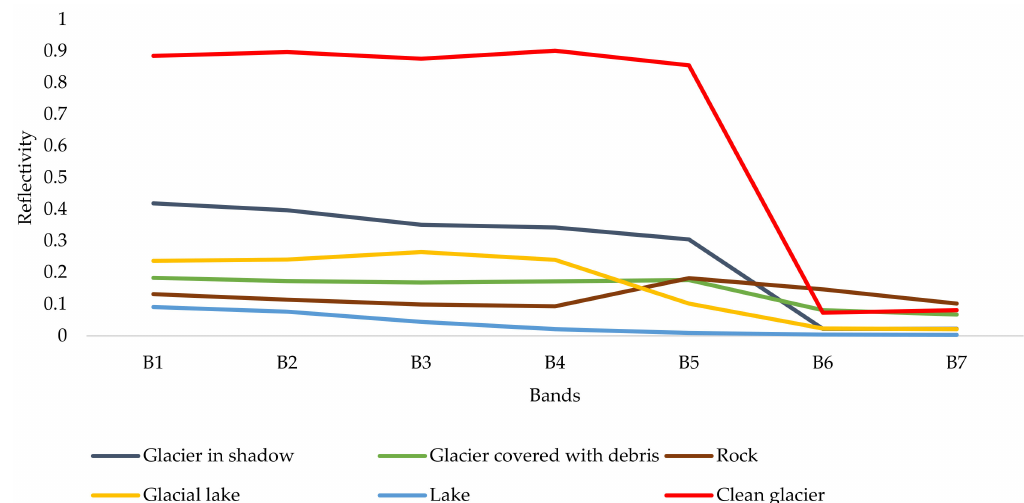
Figure 5. Average spectral reflectance of different ground